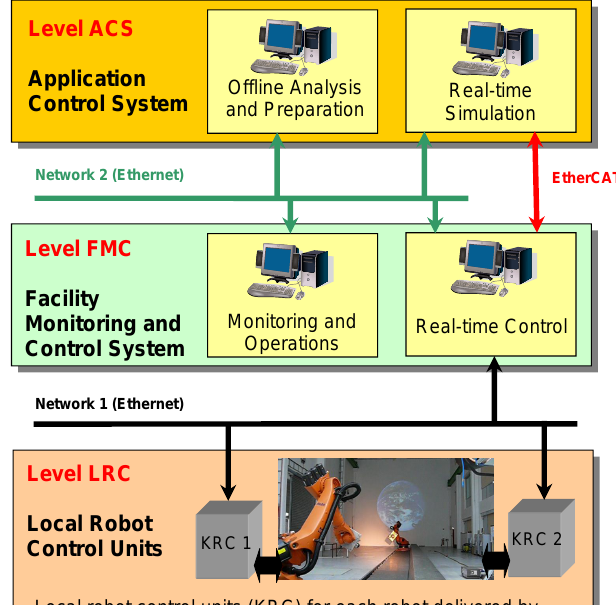
Figure 6: EPOS control system consisting of three different levels: LRC, FMC and